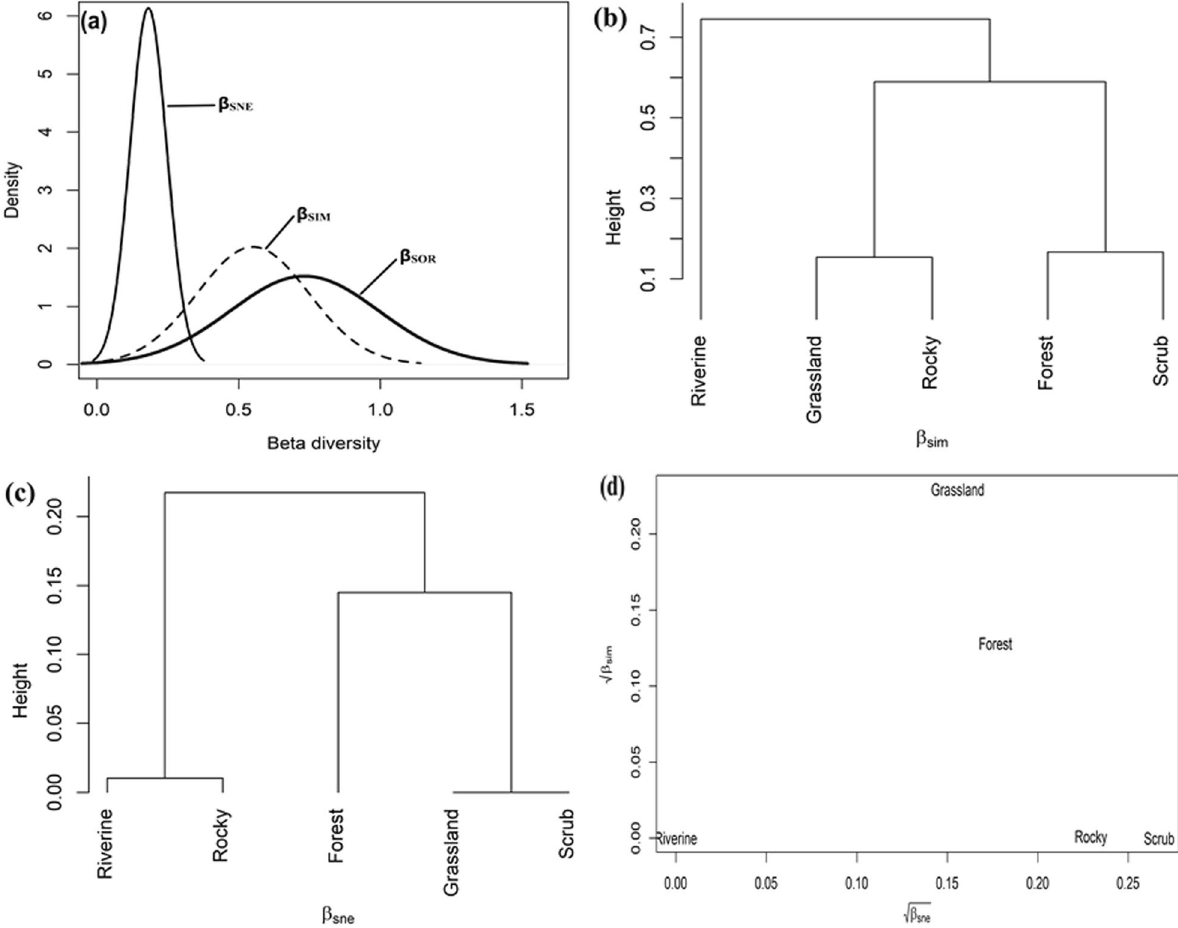
Fig. 7 Multiple-site dissimilarities across the five studied vegetation or land use types based on bird species composition. Shown are the partitioning of total dissimilarity ( β SOR -black solid line) into species turnover or replacement ( β SIM -dashed line) and nestedness ( β SNE -grey solid line) components ( a ) average clustering of β SIM ( b ) and β SNE ( c ) components of species dissimilarity among the vegetation or land use types and comparison of the square root transformed β SIM and β SNE components of β SOR between the year 2019 and 2021 for the study area by vegetation or land use type ( d